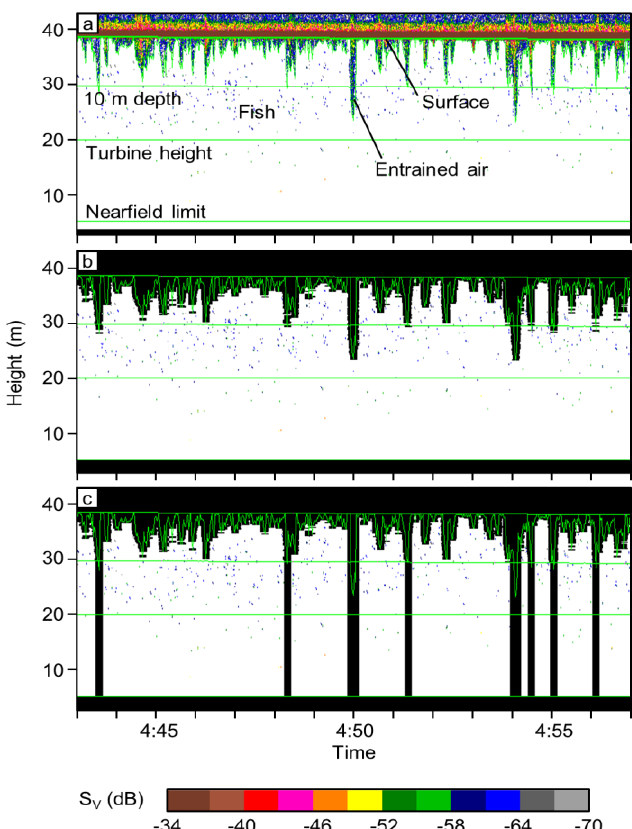
Fig. 3 Example of volume backscatter (S V ) data collected from 4:43 to 4:57 UTC on 9 December 2015. (a) Raw data, showing entrained air and lines in data processing. (b) Processed data, with entrained air removed. (c) Processed data with pings removed where depth of entrained air surpassed 10 m. Height is measured from the sea Fig. 2 Study site with deployment locations. Lower panel shows site bathymetry and proposed MHK device sites (A-D) at the FORCE test site. Location of the FAST-1 platform in winter 2015 indicated by  , summer by  . Upper panel maps made in QGIS with data obtained from GeoGratis Canada and bathymetry data from [4]. Lower panel map produced by Seaforth Geosurveys, Inc.